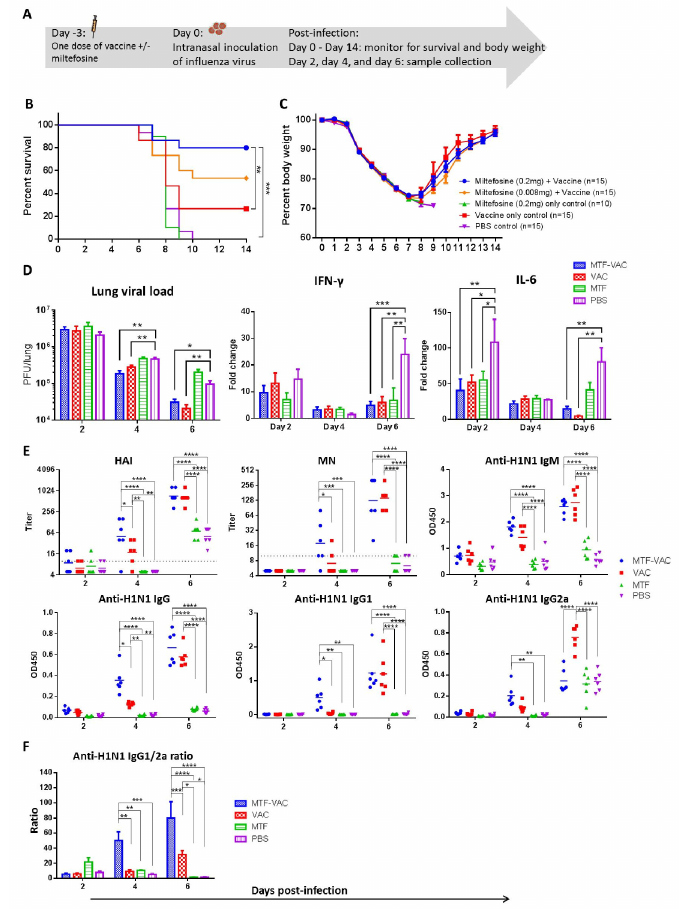
Figure 3. The effect of a single dose of vaccine on mice administrated 3 days before influenza virus challenge. Mice were vaccinated intraperitoneally with a split-virion influenza vaccine with or without miltefosine in 200 µL. On the day of the virus challenge, 10LD 50 of mouse-adapted A(H1N1)pdm09 virus was inoculated through the intranasal route in 40 µL. ( A ) Schedule of influenza vaccination, virus challenge, and sample collection. ( B ) Survival curve of mice. ( C ) Body weight curve of mice. ( D ) Pulmonary viral load ( n = 6 per group) and fold change of cytokine mRNA levels in lung tissue post-infection ( n = 3 per group). ( E ) HAI titers and MN titers of serum samples post-infection; anti-H1N1 IgM, anti-H1N1 IgG, anti-H1N1 IgG1, and anti-H1N1 IgG2a antibody levels